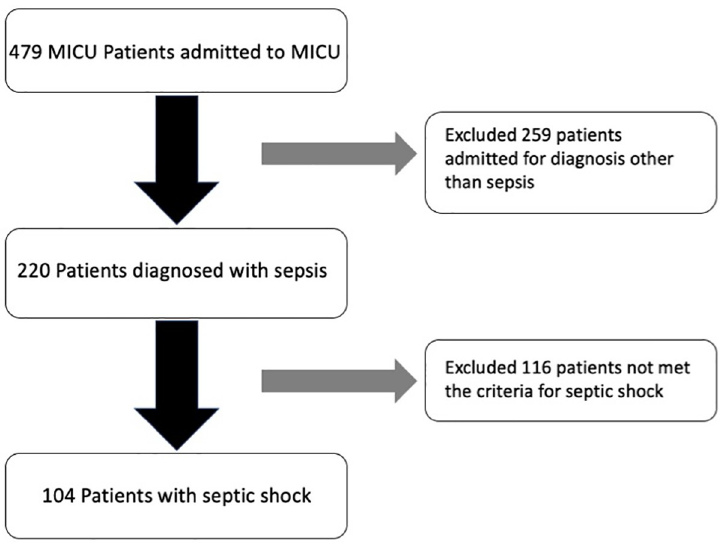
Fig 1. Patient flow